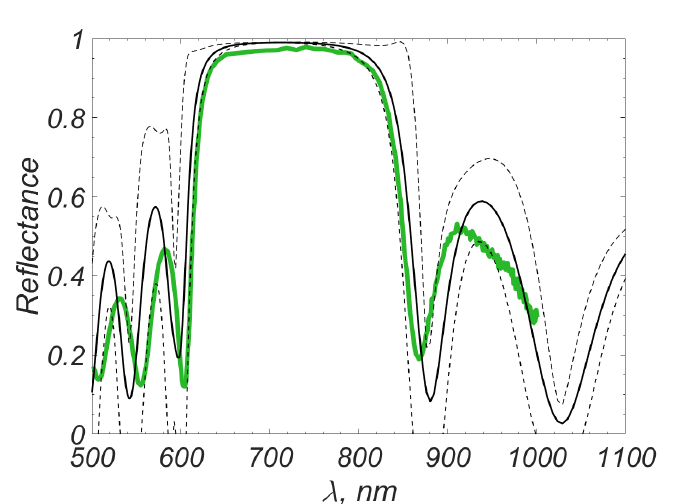
Figure 13. Photonic crystal from Figure 8. Reflection spectrum for the s -polarized wave. Green solid line is experiment [3]. Black solid line is calculation made in this work. Dashed lines are boundaries of the confidence interval according to the virtual experiment method (corresponding to two standard